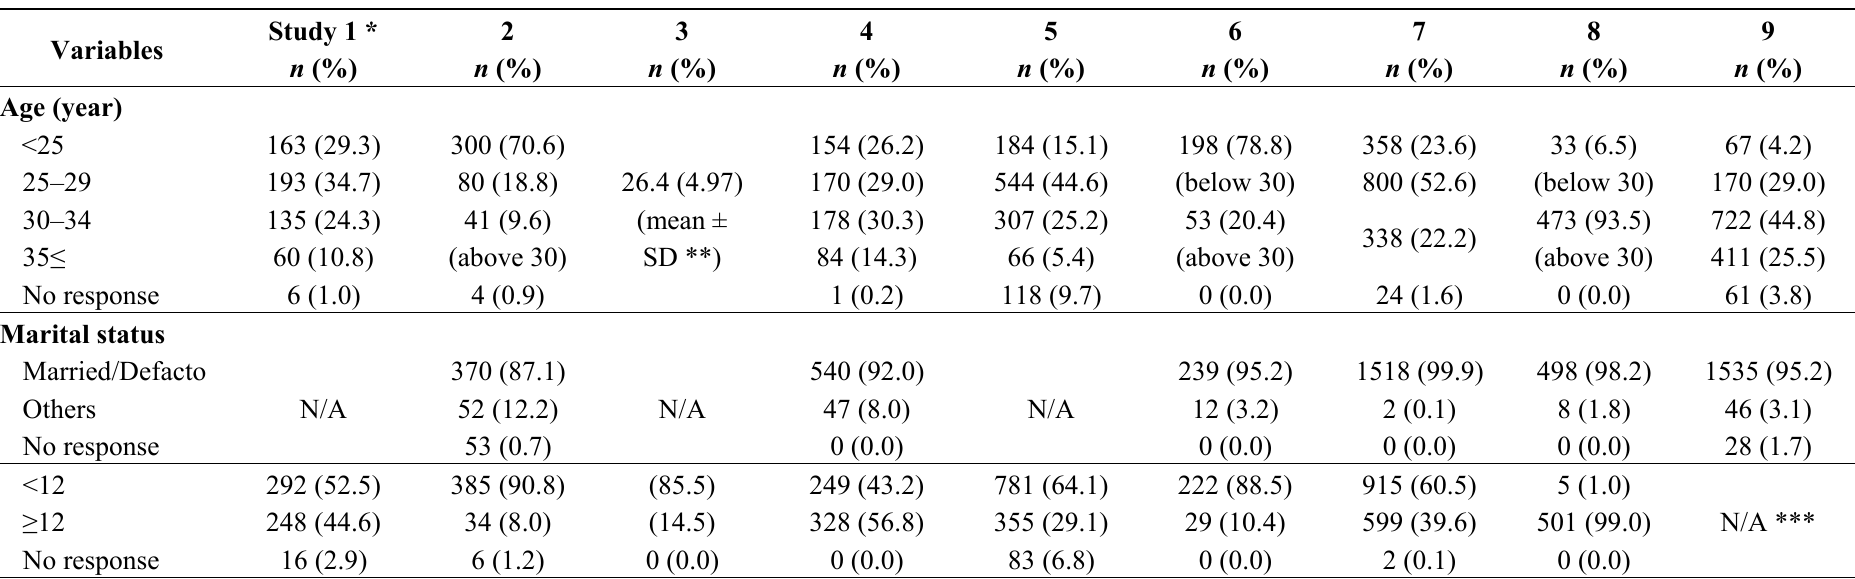
Table 2. The sample characteristics reported by mothers in each